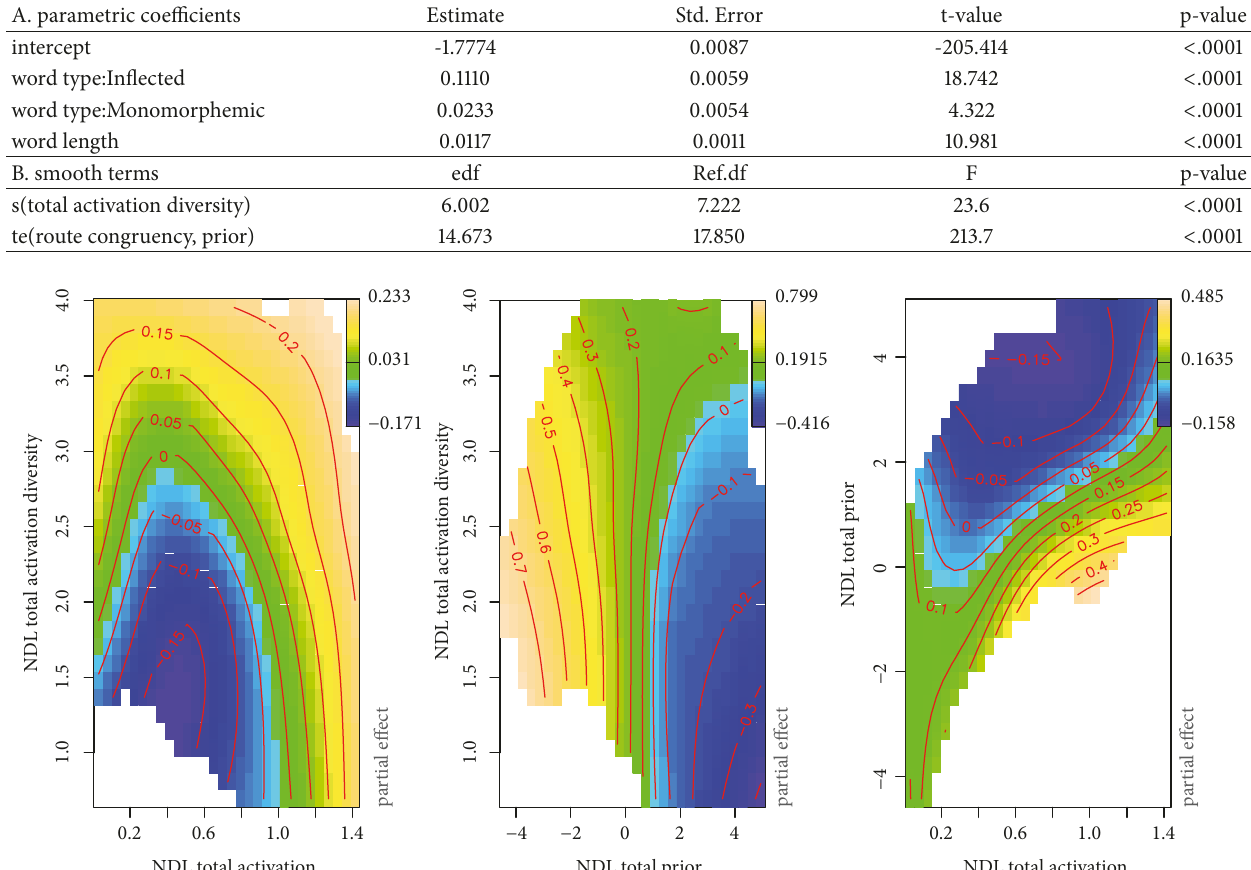
Figure 6: The interaction of total activation and total activation diversity (left), of total prior by total activation diversity (center), and of total activation by total prior (right) on RT in the British Lexicon Project, based on